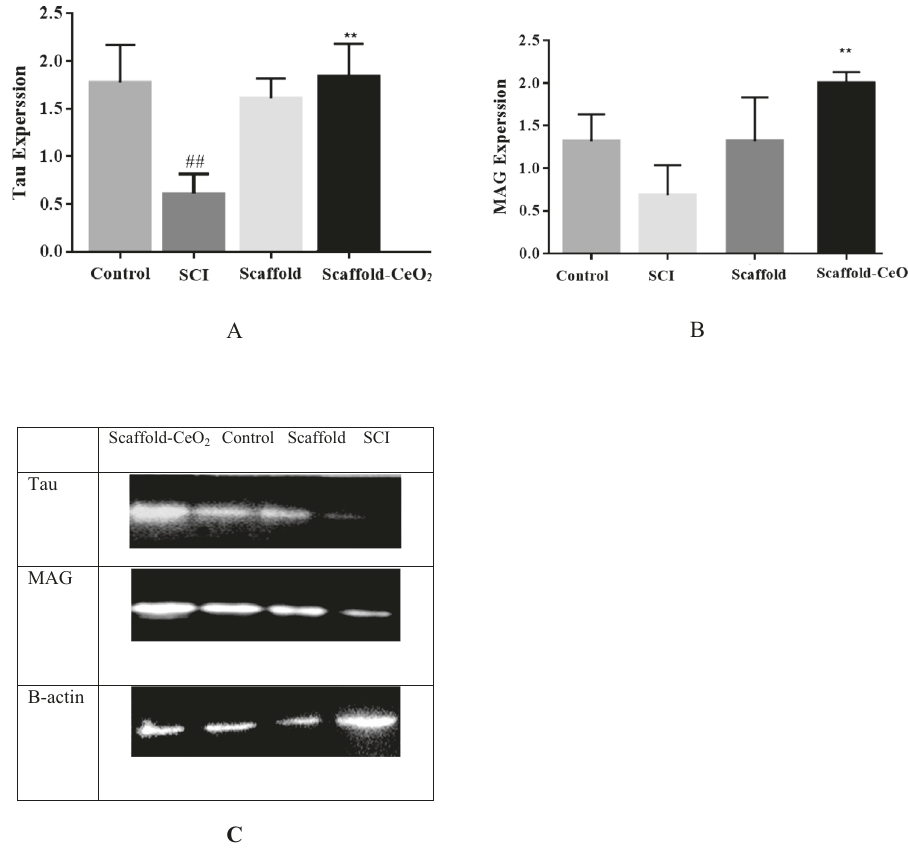
Fig. 6 Western blot analysis of GCSF protein expression. This test was performed three times and the intensity of each band was normalized to the corresponding β -actin level. A GCSF protein quanti fi cation.